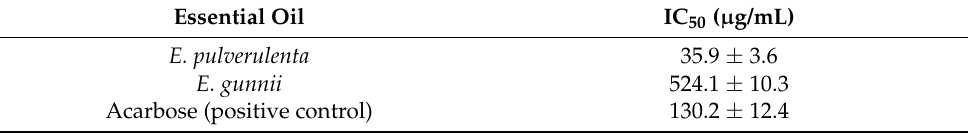
Table 5. α -Amylase inhibitory activity of E.gunnii and E. pulverulenta ‘Baby blue’ EOs. Essential